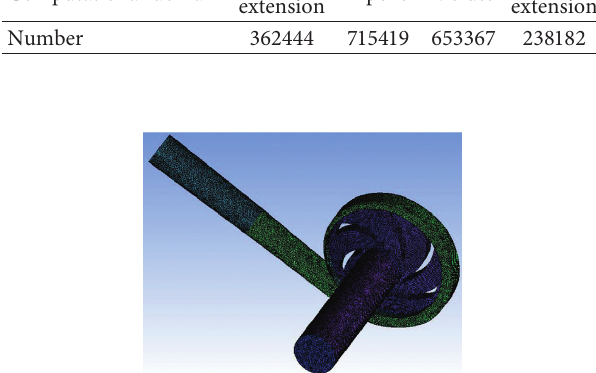
Figure 5: Mesh division model.